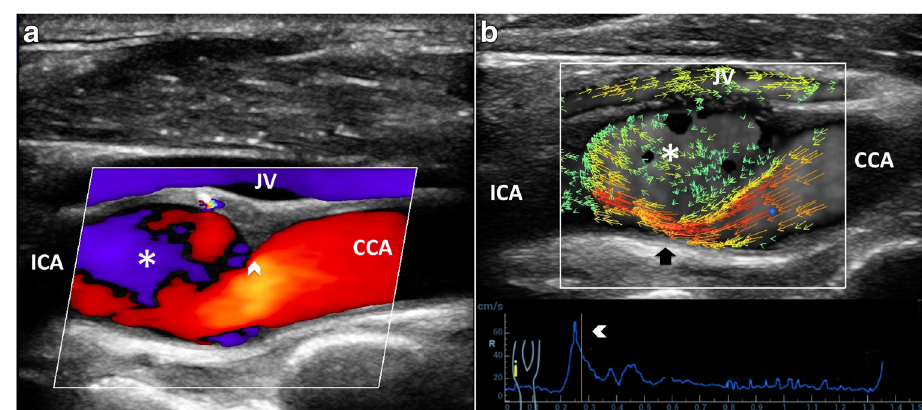
Fig. 9 Flow vorticity in low- degree stenosis and vessel dilatation. a ) B-mode depicts a rose thorn plaque ( arrowhead ) before an enlarged bulb (*); CD shows a mixture of velocities and directions. b ) VFI quantifies a large vortex ( short green vectors ) (*) during systolic deceleration ( arrowhead ). High-velocity vectors streamline toward the posterior wall ( black arrow ).